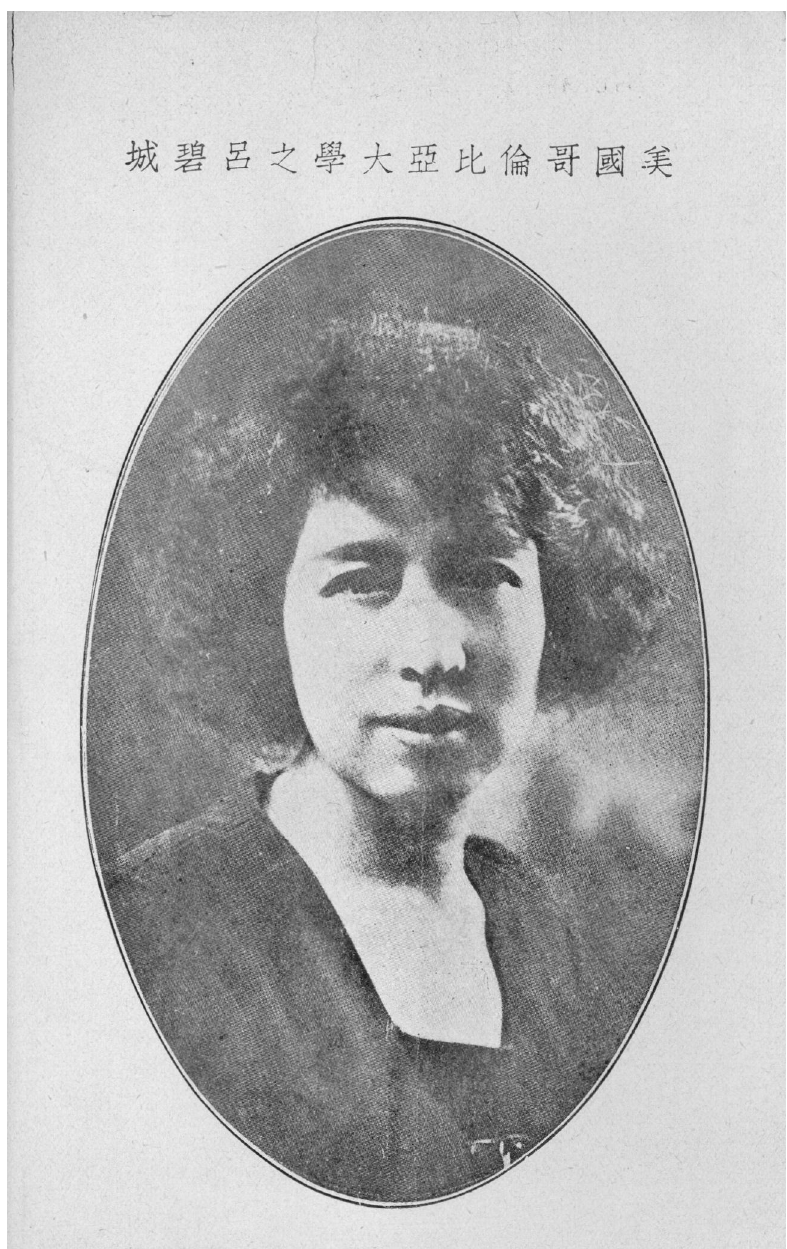
Figure 1. Lü Bicheng at Columbia University, New York. Source: Lü Bicheng ji (Beijing: Zhonghua shuju, 1929).